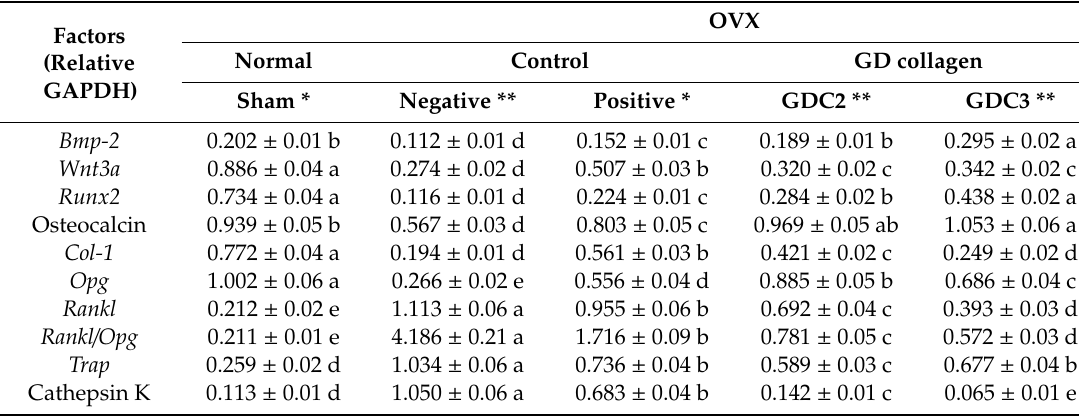
Table 4. The E ff ect of GD collagen on mRNA expression levels in the tibia of OVX rats through reverse transcriptase-polymerase chain reaction (RT–PCR)